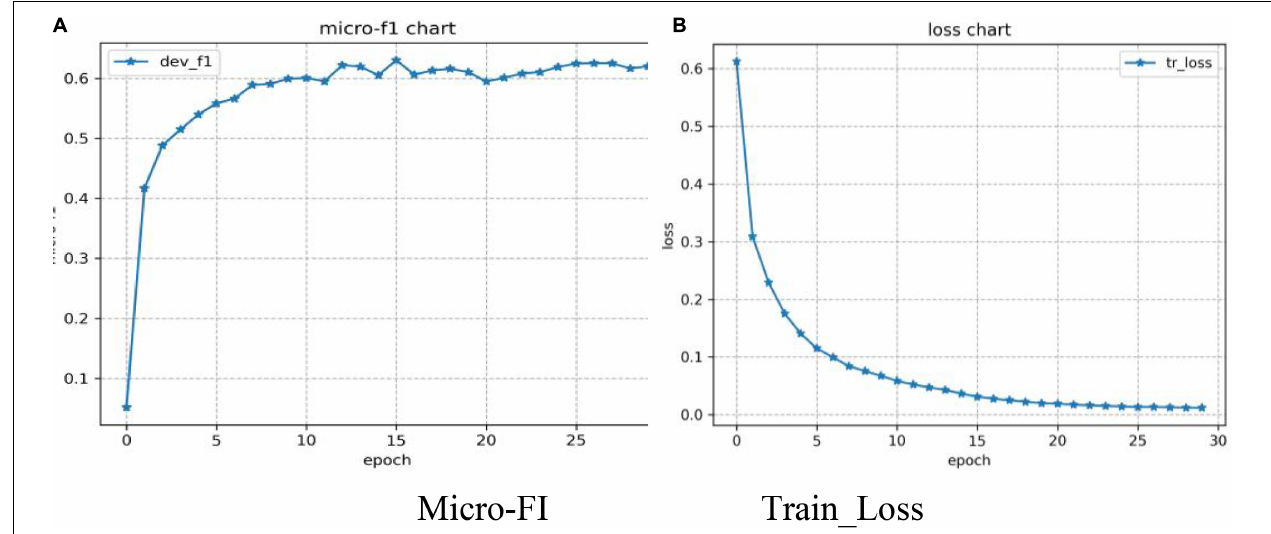
FIGURE 6 | Changes in the BERT-BiGRU-MHA model on the TikTok dataset. (A) Micro-FI; (B) Train_Loss.